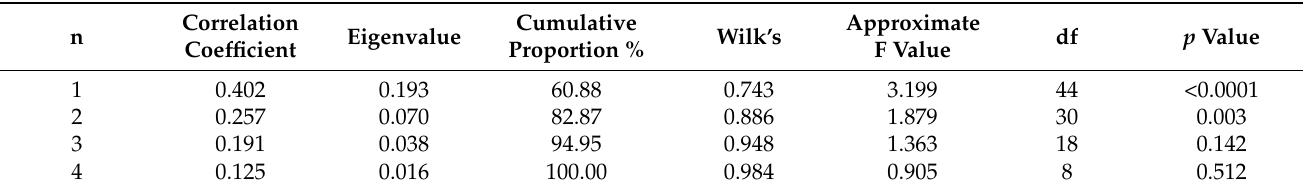
Table 4. Canonical correlation analysis of the scores of subjective wellbeing dimensions with per- ceived neighbourhood environment variables X1–X11.